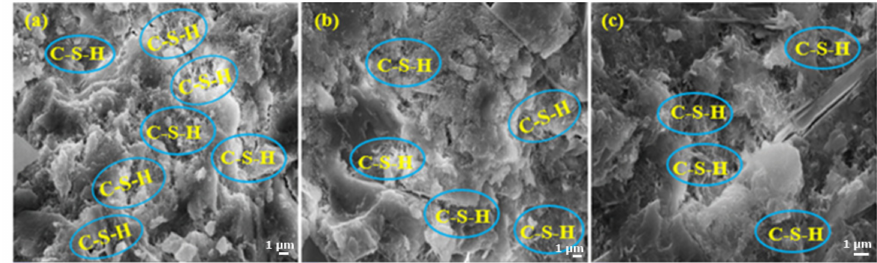
Figure 15. 28-days SEM images of ( a ) Control, ( b ) FBP5, and ( c ) FBP10